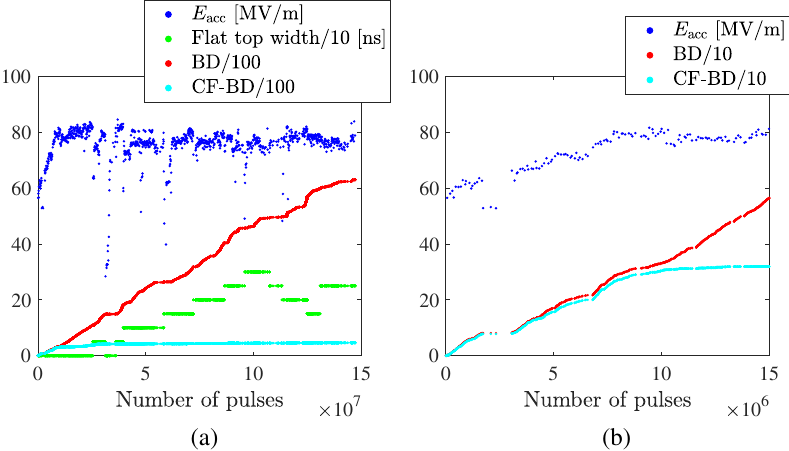
FIG. 15. Summary of the conditioning history of THU-CHK-#1. (a) Full history. The blue dots denote E denote flat top pulse width [ns] divided by 10, the red dots denote total breakdown number divided by 100, and the cyan dots denote number of CF-BDs divided by 100. (b) History of the first 1 . 5 × 10 7 pulses. The blue dots denote E breakdown number divided by 10, and the cyan dots denote number of CF-BDs divided by 10.